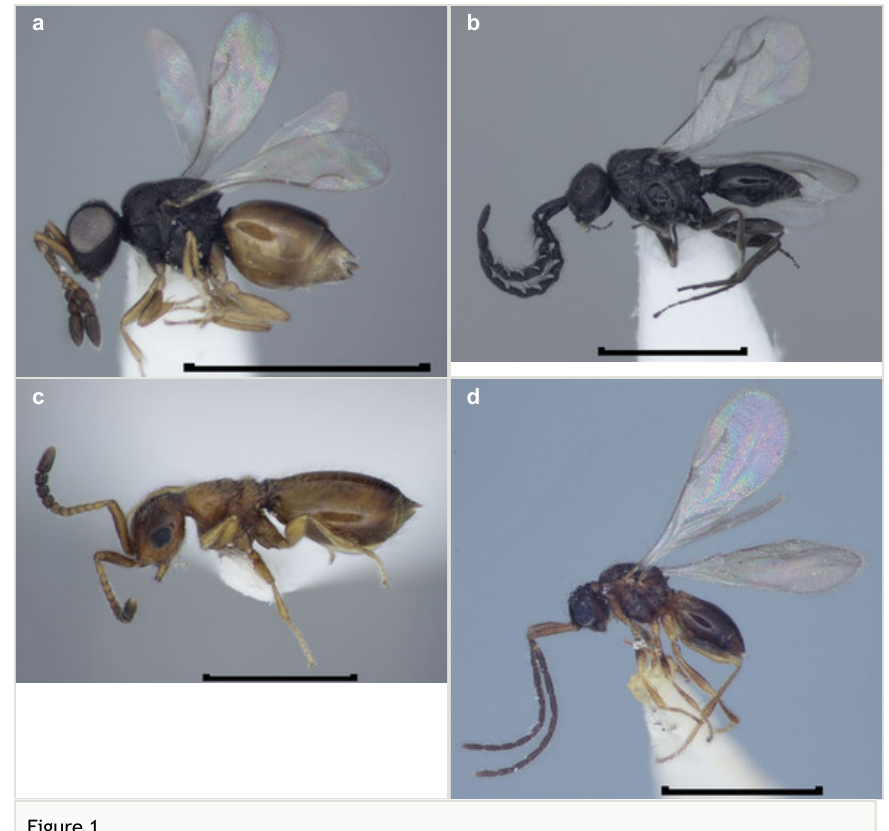
Figure 1. Habitus of representative British Ceraphronoidea (scale bar = 1